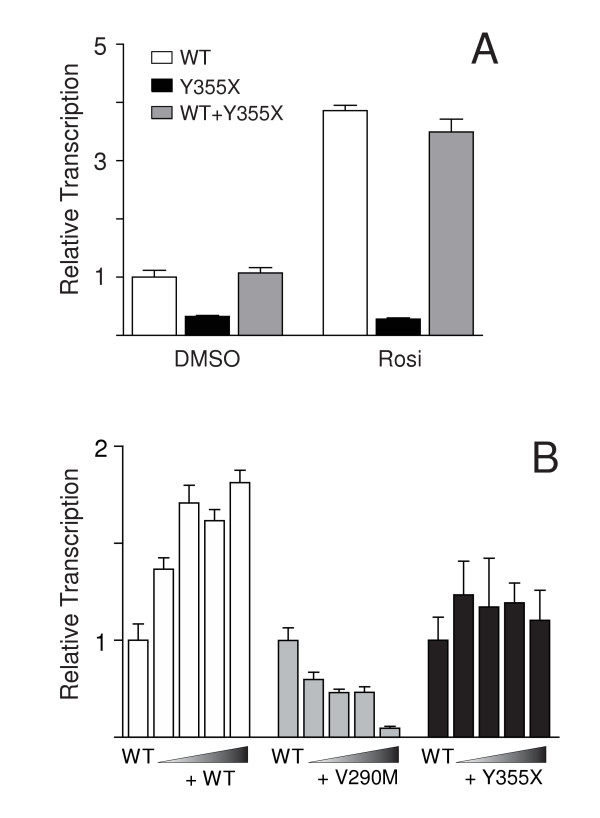
The Y355X mutant receptor does not inhibit the activity of wild-type PPARγ. (A) WT and Y355X receptors (1 and 15 ng respectively) were transfected into NIH 3T3 cells individually or in combination in the presence or absence of 5 μM rosiglitazone (Rosi). (B) NIH 3T3 cells were transfected with the combination of 1 ng of WT PPARγ and increasing amounts of either the WT (1–4 ng), the dominant/negative mutant V290M (1–4 ng) or the Y355X mutant receptor (1–15 ng) as indicated. Data are normalized to the transcriptional activity of 1 ng of WT receptor and are presented as means ± SD (n = 3).